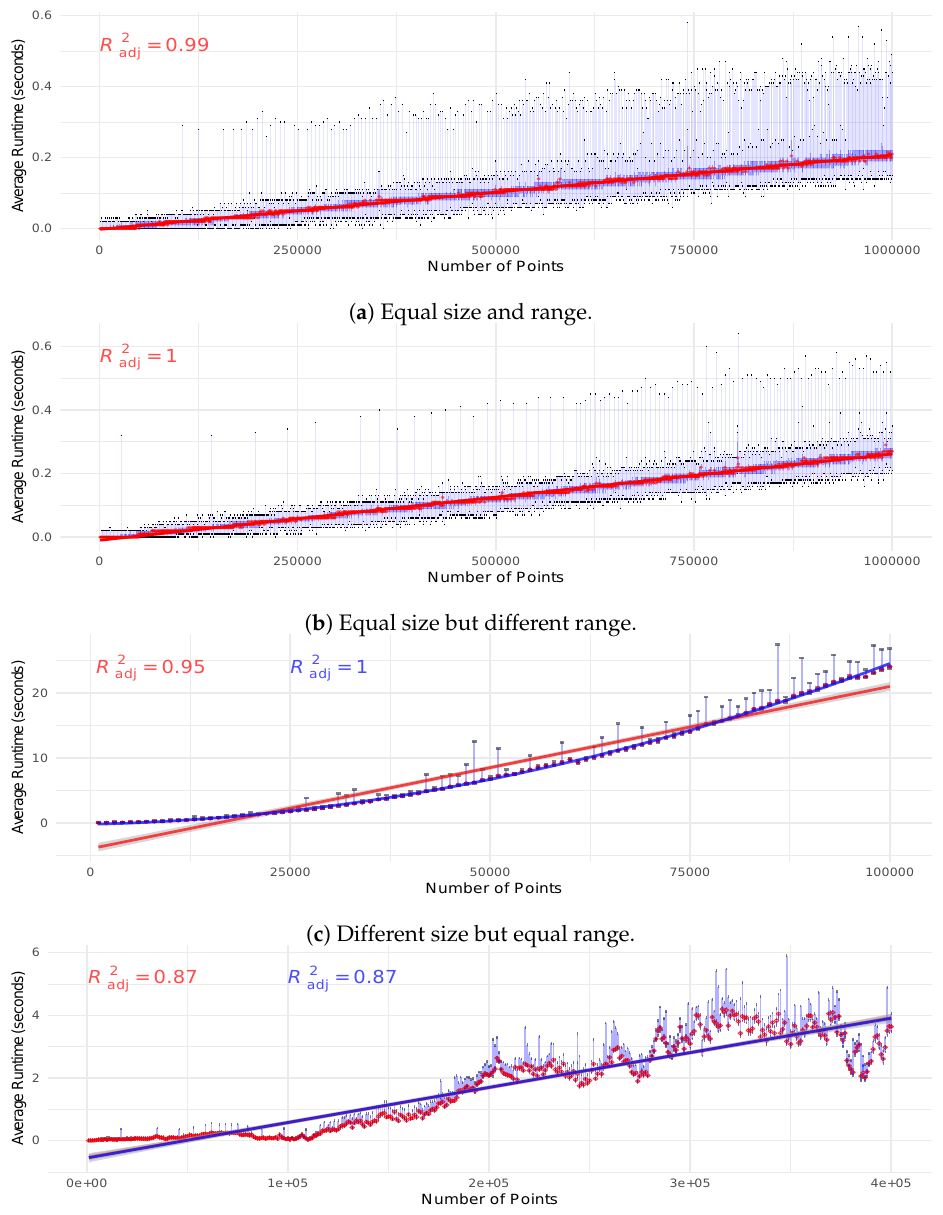
Figure 8. Median running time in the computation of bottleneck distance between two diagrams with varying size and range settings fitted with regression curves. Superimposed are the minimum and maximum running times over the 100-run simulation per unit of 1000 points to illustrate the running time range, and the narrow darker blue band to show the